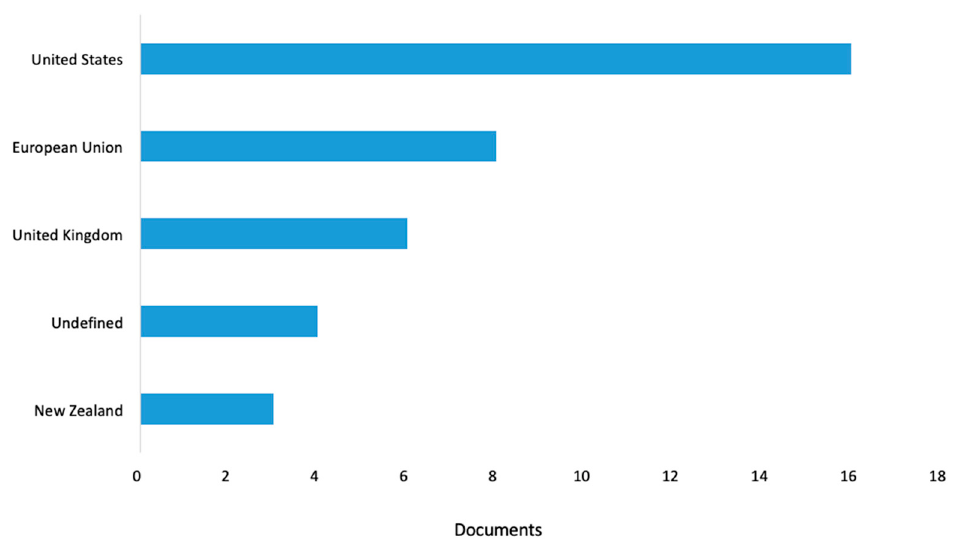
Figure 2. Documents by country or territory (top five countries/territories) (source: own authorship).